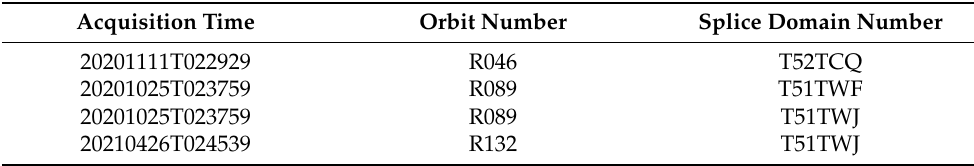
Table 2. Images taken by Sentinel-2B under product grade